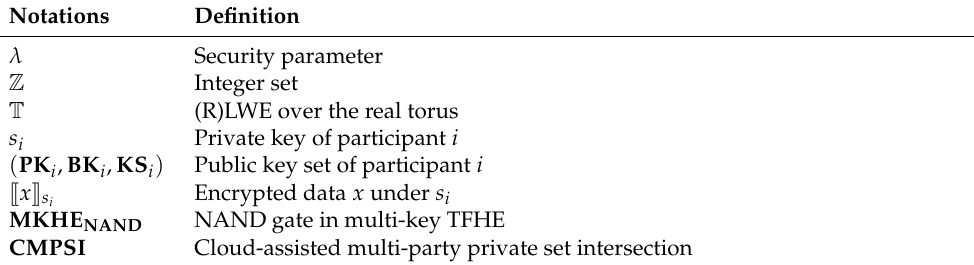
Table 2. Notation